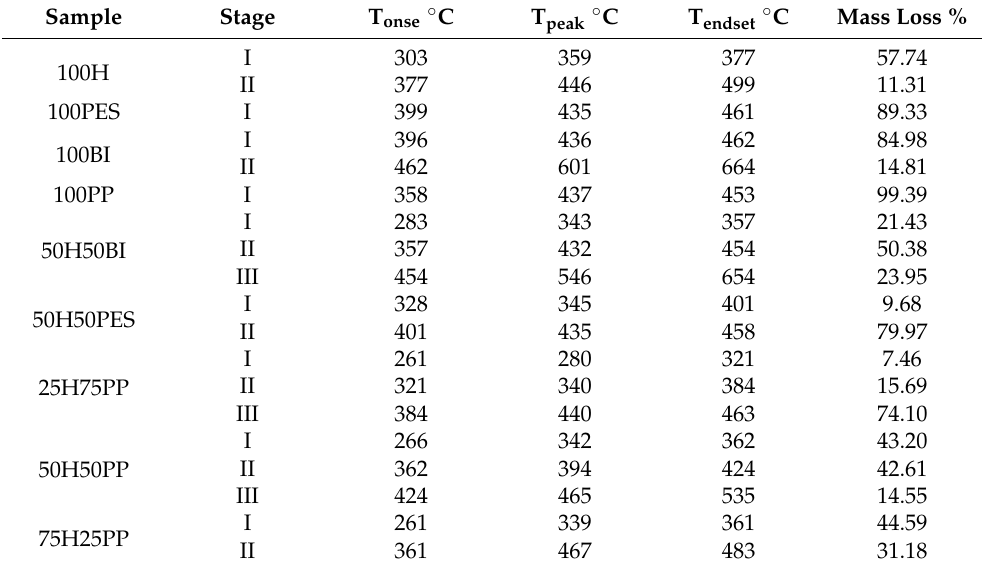
Table 3. Thermogravimetric parameters of the investigated samples.